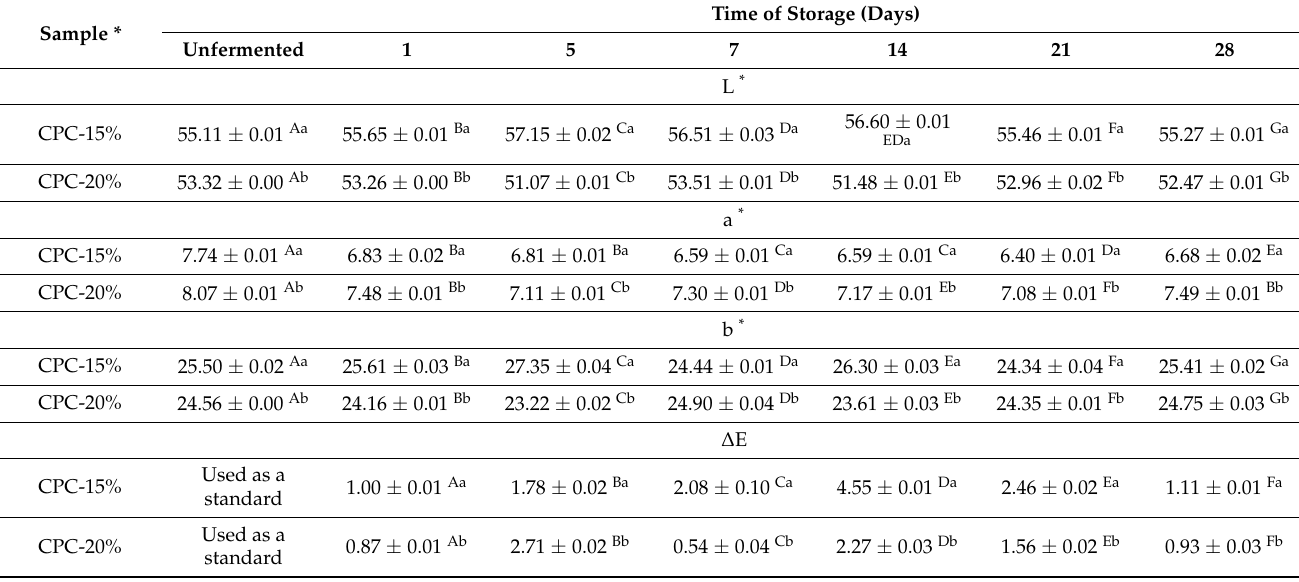
Table 2. Color parameters and total color difference ( ∆ E) of samples during the storage